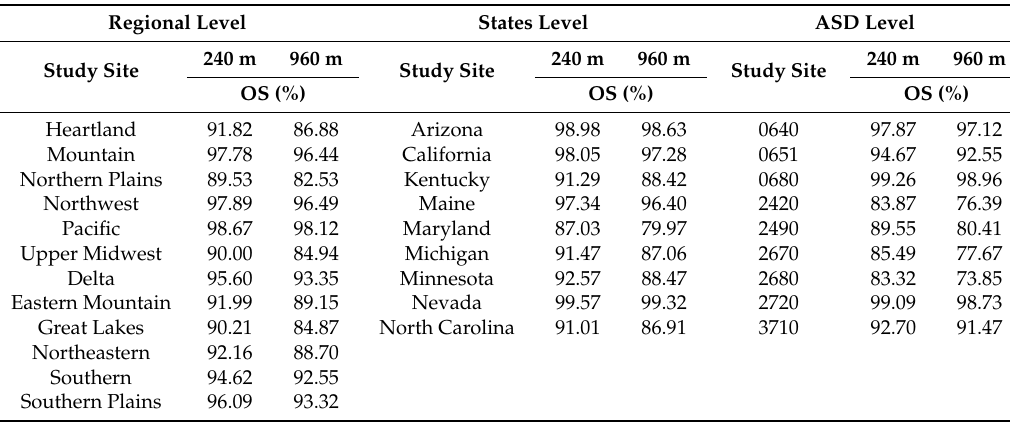
Table 5. The Overall Similarity (OS) of the upscaled maps for all study sites.